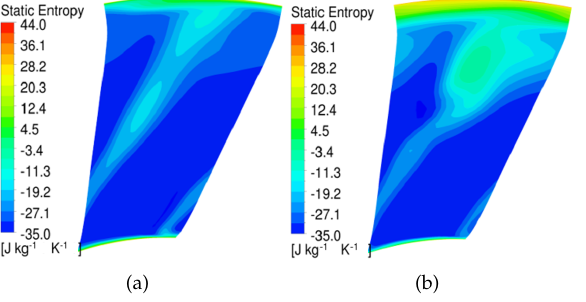
Figure 7. Comparison of entropy contours at the bypass exit. ( a ) OP1. ( b ) OP3.